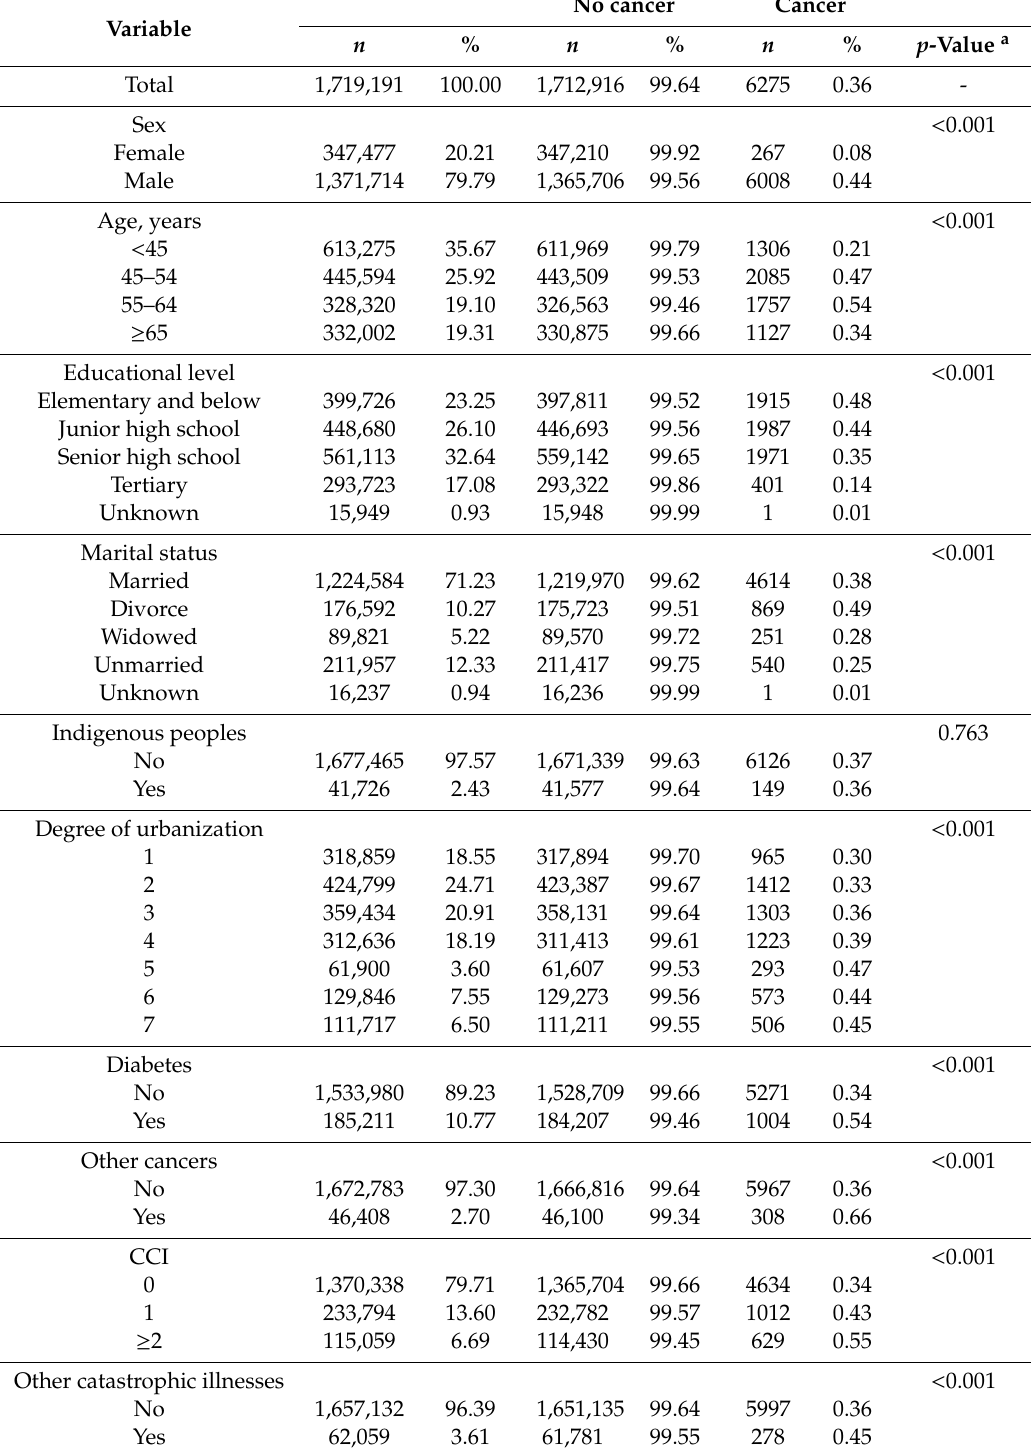
Table 2. Bivariate analysis of the high-risk populations with and without oral cancer who had undergone oral cancer screening (observed until